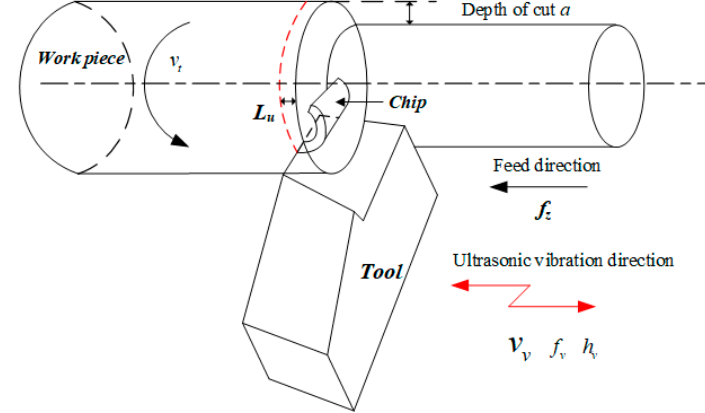
Figure 1. Illustration of the acoustic vibration-assisted turning.